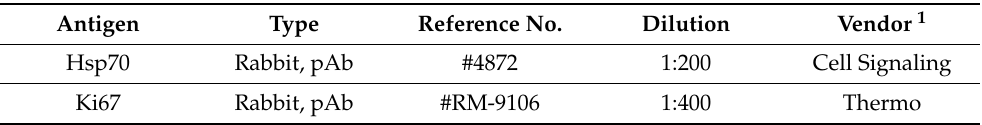
Table 3. Antibodies and conditions used for immunohistochemistry and immunofluorescence. pAb: polclonal antibody, Hsp70: heat shock protein-70, Ki67: marker of proliferation.